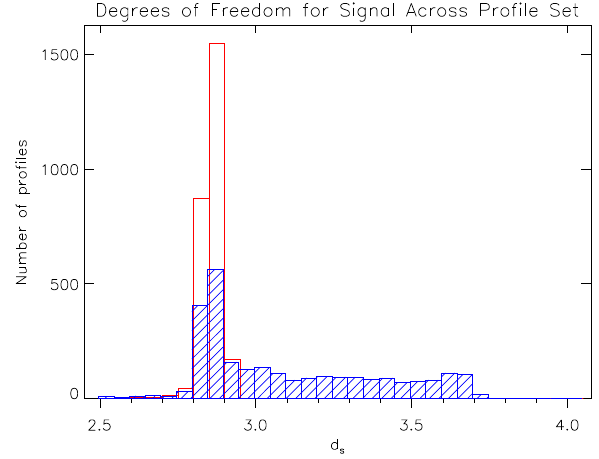
Figure 5. Degrees of freedom for signal across the profiles set used in the information content analysis using all 14 AMSR2 channels. Results assuming a four-variable retrieval vector are shown with open red bars and the five-variable retrieval vector with hatched, blue